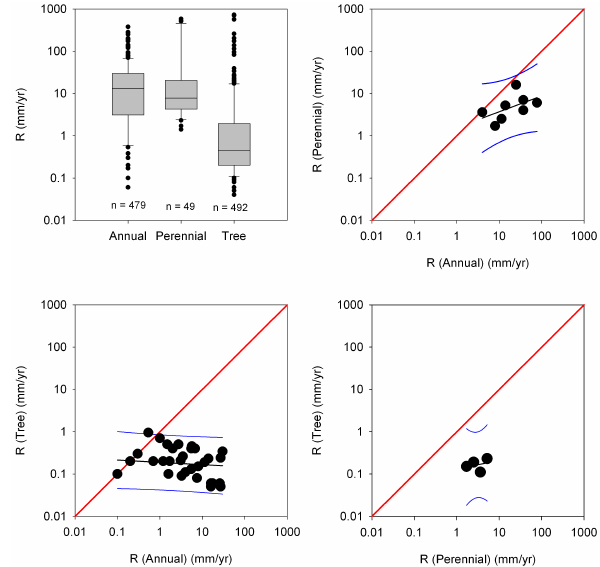
Fig. 5. The influence of vegetation on recharge. The boxplots compare all recharge estimates under the three groups of vegeta- tion types. The scatterplots show where estimates of recharge have been made under two vegetation types at the same site by the same author using the same